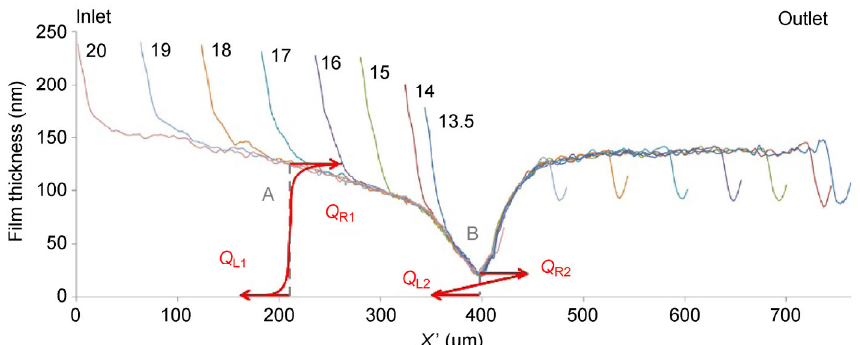
Fig. 8 Centerline film thickness profiles plotted against modified x ’ coordinate.